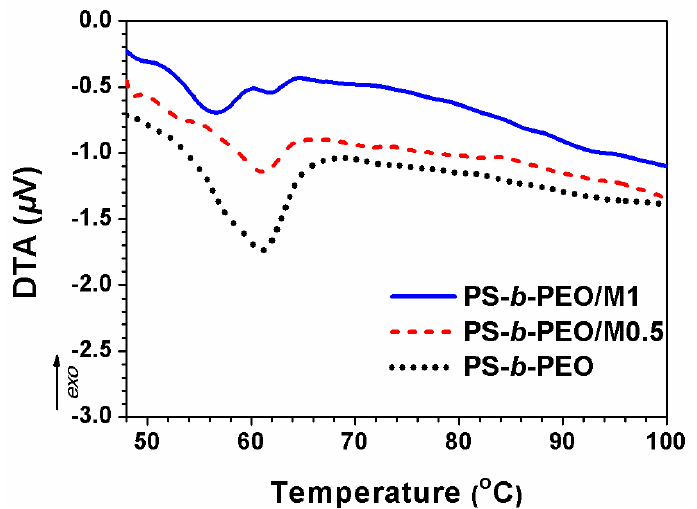
Figure 3d that the micro-phase separation of the membrane was completed after 10-h annealing process at 90 °C, worm-like domains of dark PEO dispersed in the bright PS matrix. Figure 2. DTA curves of sample PS- b -PEO, PS- b -PEO/M0.5 and PS- b -PEO/M1 at a heating rate of 10 °C/min.